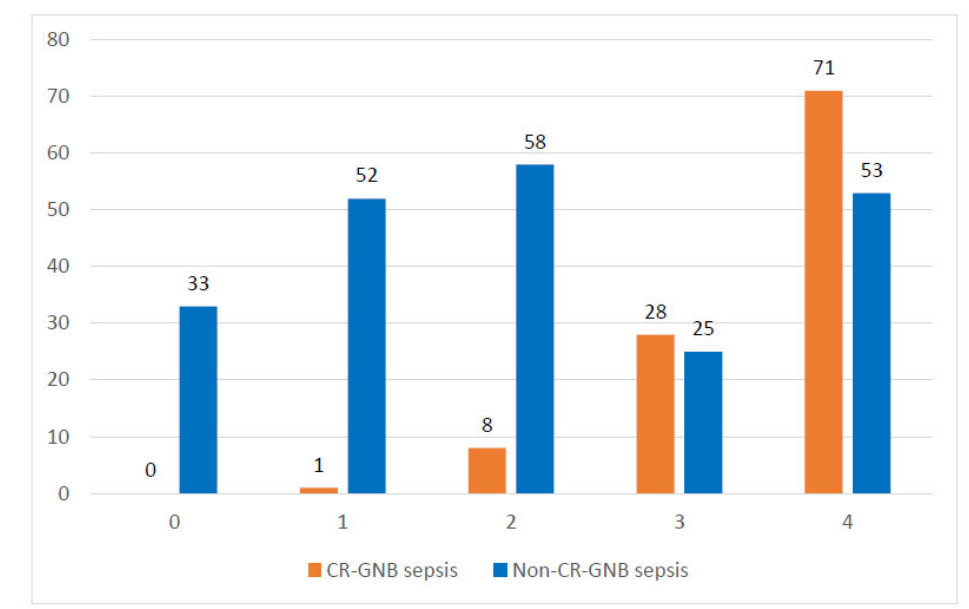
Figure 2. Distribution of groups of sepsis episodes according to the score obtained from the case–case–control design study already published [5]. Score for CR-GNB sepsis: infection prior to the sepsis episode, one point; previous use of mechanical ventilation, one point; previous use of carbapenem, one point; length of hospital stay greater than or equal to 19 days, one point. Each score factor present contributed to one point for the final score in each sepsis episode in the entire cohort.